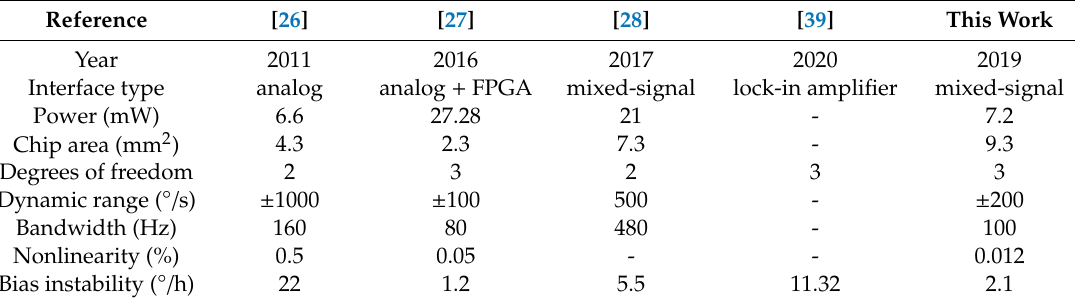
Table 2. Summary of published state-of-the-art MEMS